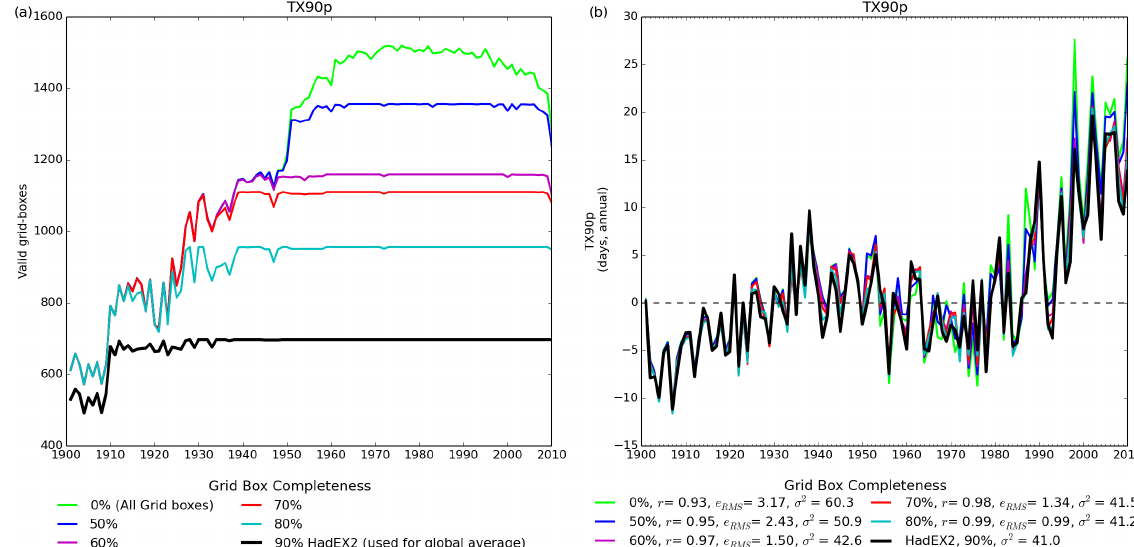
Figure 1. (a) Numbers of grid boxes covered given different completeness requirements, for TX90p ( T max > 90th percentile). The total coverage is shown in light green, whereas the coverage used when calculating global averages is in black, with a range of other completeness percentages shown in between. (b) The time series for global average of TX90p of HadEX2 (black) and the completeness percentages from panel (a) . Also shown are the comparisons of other completeness criteria to that used in HadEX2 (90%) using the correlation coefficient, r , the root mean square error e RMS and the variance, σ 2 .